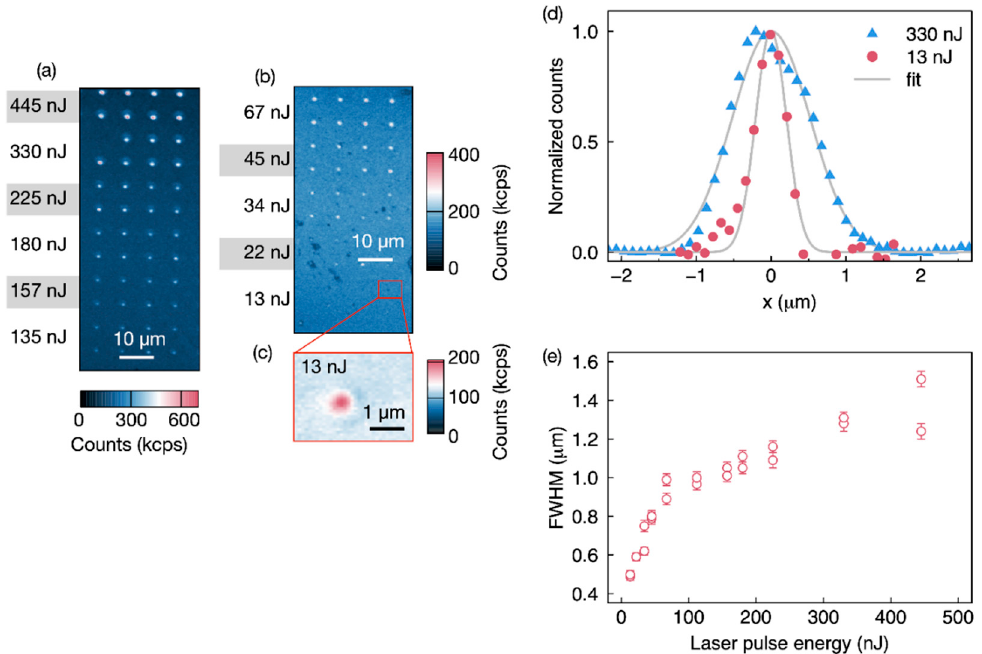
Nanomaterials 2021 , 11 , x FOR PEER REVIEW 8 of Figure 2. Confocal maps of high-purity semi-insulating (HPSI) 4H-silicon carbide (SiC) containing arrays of color centers laser written with a 515 nm fs-laser at single pulse energies ranging from ( a ) 135-445 nJ to ( b ) 13–67 nJ. ( c ) It shows a zoom in of the 13 nJ spot. ( d ) Point spread function for laser written spots created with 13 and 330 nJ per pulse. Fit is with a Gaussian profile. The confocal excitation laser is at 730 nm and 5 mW, while the collection is above 850 nm. ( e ) Lateral (X-direction) full with half maximum (FHWM) of the fabricated areas versus laser pulse energy.